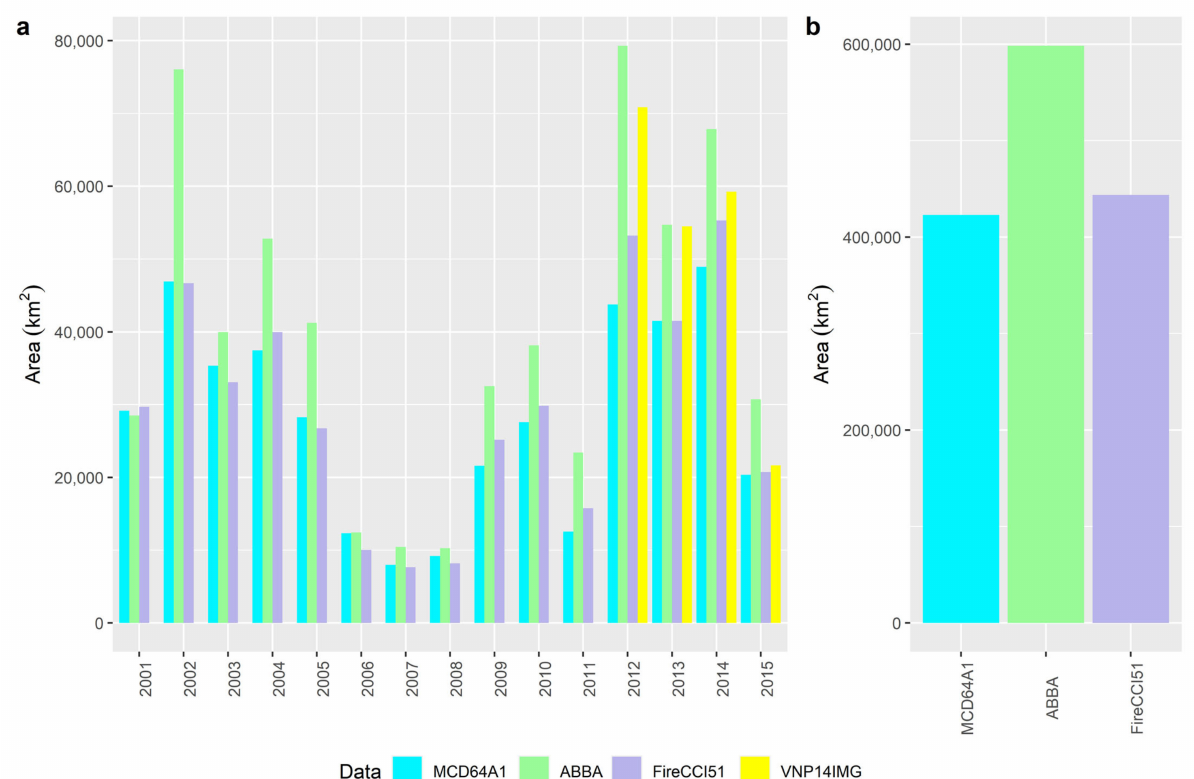
Figure 4. Comparisons of ( a ) annual total area and ( b ) grand total area of burned areas as mapped by the MCD64A1, ABBA, FireCCI51, and VNP14IMG data over areas in circumpolar boreal forest and tundra north of 60 ◦ N. The grand total area of burned areas as mapped by VNP14IMG is not visualized in ( b ) because of its shorter temporal